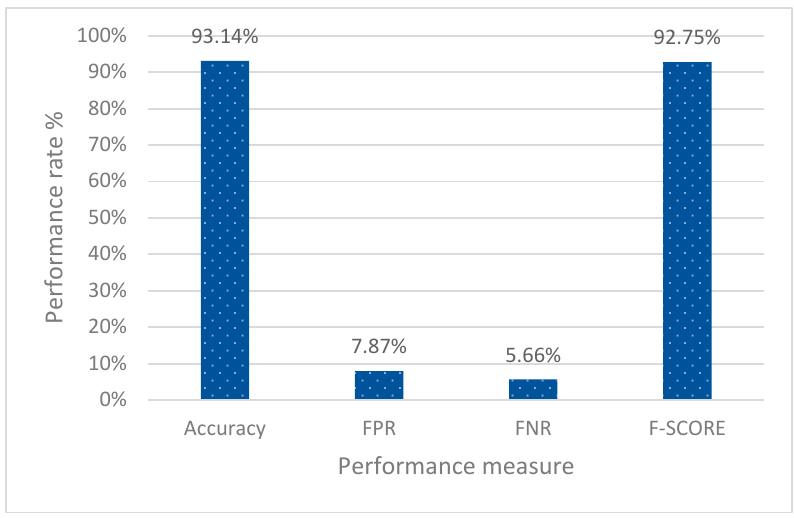
Figure 4. The effectiveness of the proposed scheme.